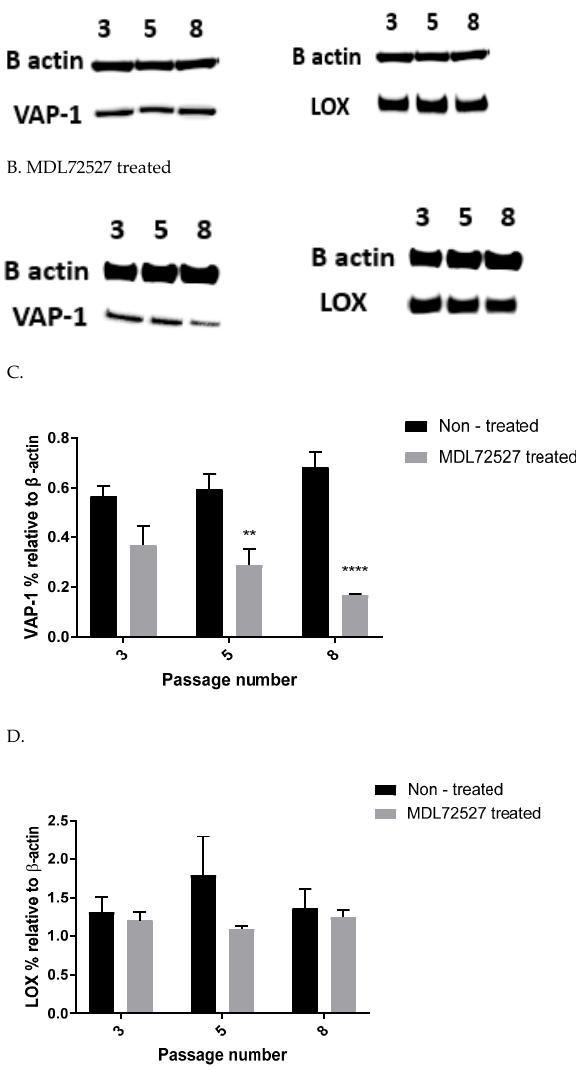
Figure 4. VAP-1 and LOX protein expression in non-treated VSMCs from passages 3, 5, and 8 ( A ) and after 1 h MDL72527 treatment ( B ). VAP-1 expression (expressed as percentage relative to β -actin) in non-treated (control: black bars) and MDL72527 treated (grey bars) rat aortic VSMCs from passages 3, 5 and 8 ( C ). There was no significant difference in VAP-1 expression over passage ( p > 0.05). At passage 5, (** p < 0.01) and passage 8 (**** p < 0.0001) for MDL72527 treated vs. non-treated cells. LOX expression (expressed as percentage relative to β -actin) in non-treated (control: black bars) and β APN treated (grey bars) rat aortic VSMCs from passages 3, 5, and 8 ( D ). There was no significant difference in LOX expression over passage, or between non-treated vs. MDL72527 treated cells ( p > 0.05). Values are mean ± S.E.M. (n =